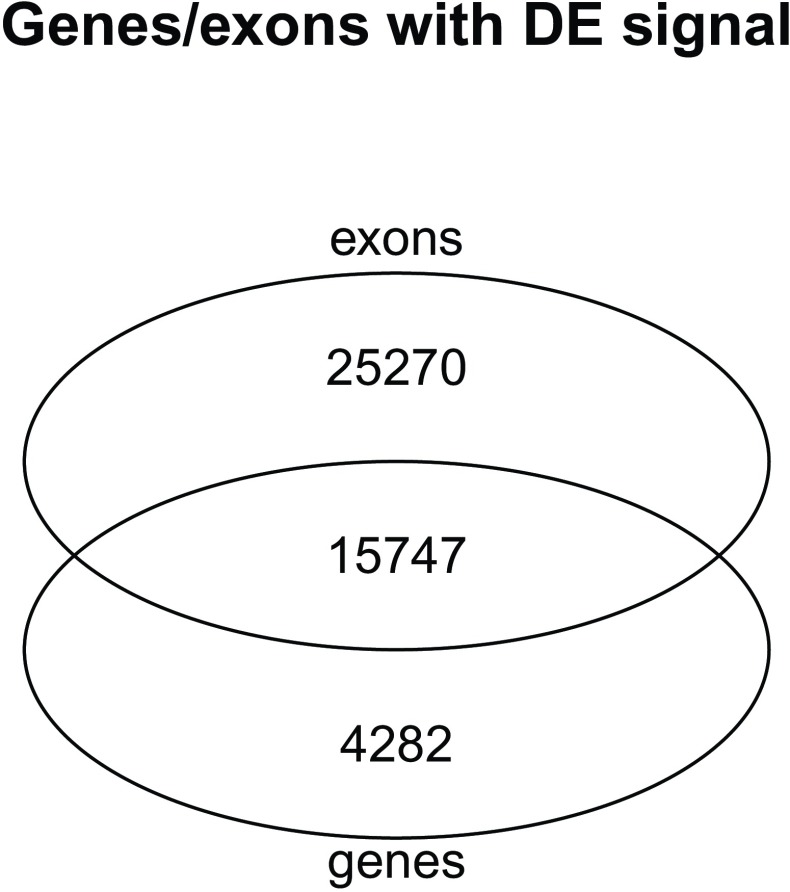
Venn diagram of the overlap between DE genes and genes with at least one exon DE.